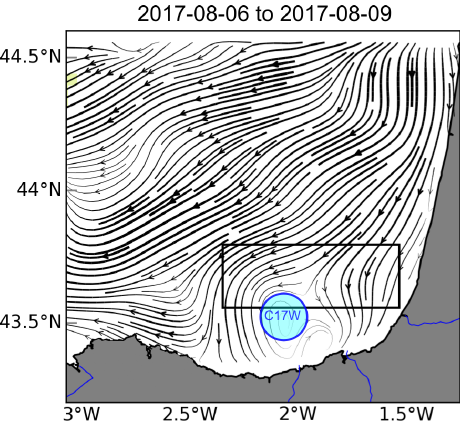
Figure A1. Lagrangian residual currents (LRC) for the period of 6 to 9 August, the persistent C17W eddy is still visible after the change in wind